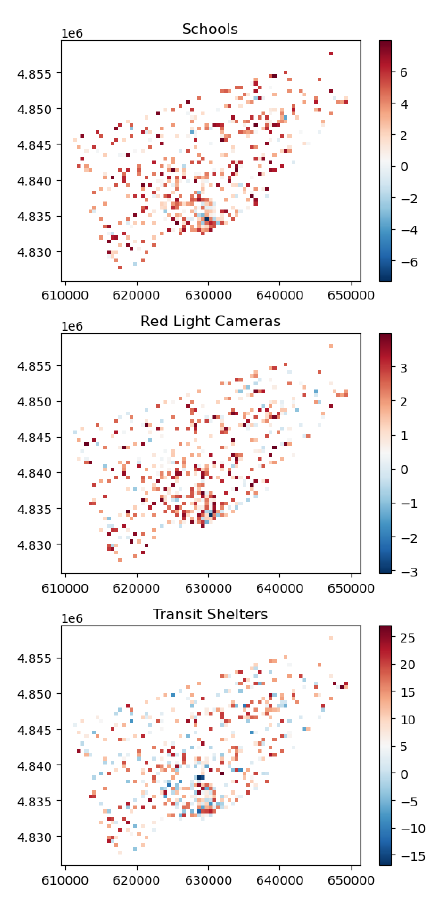
Figure 5 . Scenario 1 generated geo-intervention.